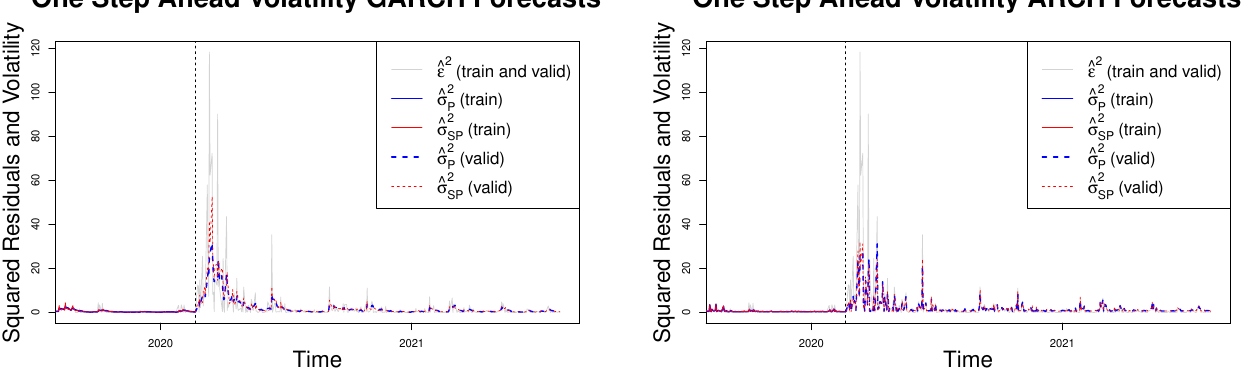
Figure 2. The left plot shows the one-step-ahead GARCH and SPMLGARCH forecasts and the right plot shows the one-step-ahead ARCH and SPMLARCH forecast. The forecast period is from t = 926, . . . ,1305, or 21 Febuary 2021 to 5 August 2021. The vertical black dashed line indicates the start of the forecasting period. The red and blue curves indicate the semiparametric and parametric models, respectively. The solid curves represent fitted values of the conditional variance based on the training data set and the dashed curves denote the forecasts based on the validation data set. The forecasts were calculated using a rolling window scheme of window size 925.